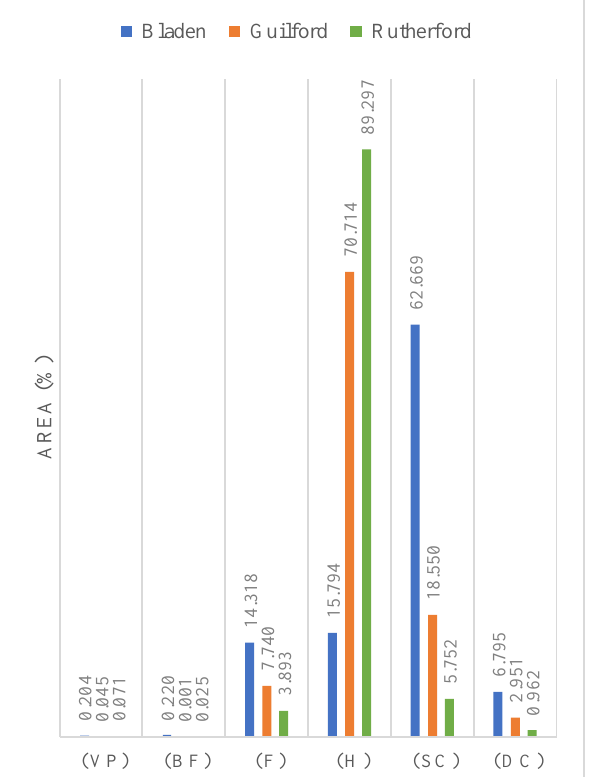
Figure 4. Non-food deserts: 2008-2019 average shares of the farmland area under alternative uses. Notes: VP = vegetables & produce, BF = berries & fruits, F = fallow, H = hay, SC = single season, DC = double season.